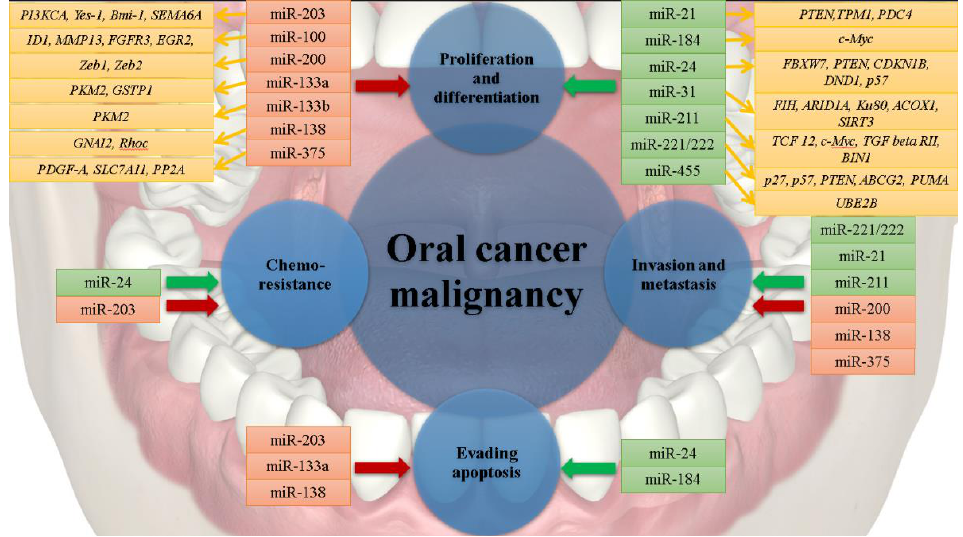
Figure 2. Associations between miRNAs and their target genes in oral cancer. As illustrated, upregulated miRNAs (in green-colored boxes) and downregulated miRNAs (in salmon-colored boxes) can have significant effects in controlling various levels of cell homeostasis, by either reducing expression levels of tumor suppressor genes or by increasing expression levels of oncogenes or tumor suppressor genes (in yellow-colored boxes). As a result, normal cells evolve progressively to a neoplastic state, achieving special properties known as “the hallmarks of cancer” (dark-green and dark-red arrows).